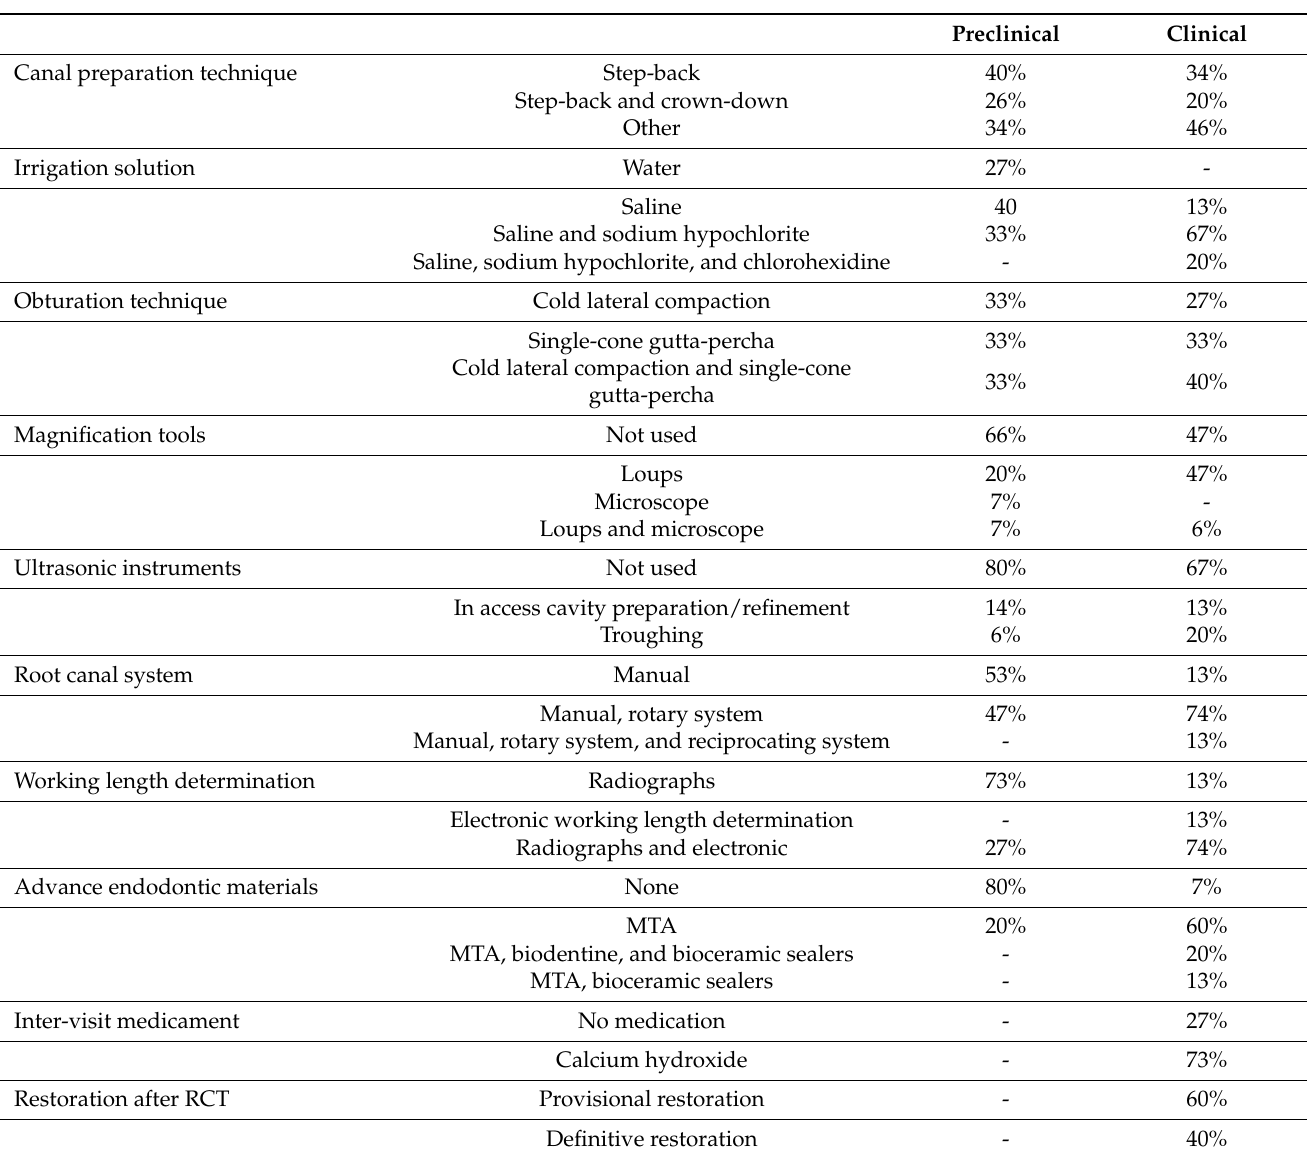
Table 3. Distribution of canal preparation and obturation techniques, use of endodontic materials, and complexity of endodontic cases in Saudi